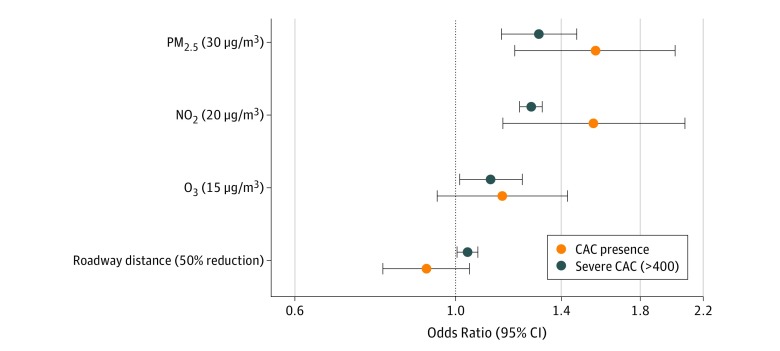
Odds Ratio of Detectable and High-Level Coronary Artery Calcium (CAC) Associated With Long-term Exposure VariablesOdds ratios and 95% CIs (error bars) for the presence of CAC and severe CAC (>400 Agatston units) adjusted for age, sex, body mass index, smoking status, smoking years, cigarettes per day, alcohol consumption, education, exercise, urbanization, region, distance to hospital, and Beijing residence (yes or no). NO2 indicates nitrogen dioxide; O3, ozone; and PM2.5, particulate matter with aerodynamic diameter less than 2.5 μm.